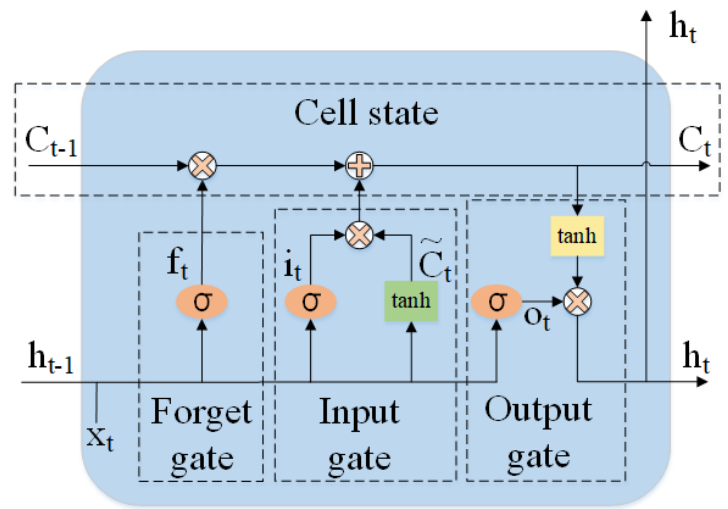
Figure 2. Schematic diagram of LSTM network structure.